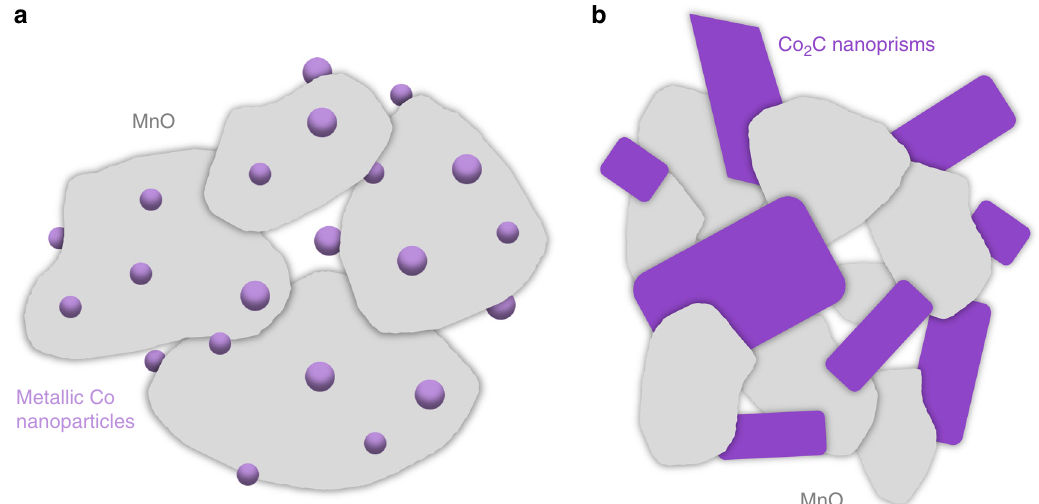
Fig. 7 Schematic drawing of the structure of the active catalysts based on TEM and XRD analysis. a Co 1 Mn 3 – Na 2 S consists of metallic Co nanoparticles of ~10 nm dispersed on MnO support and b Co 3 Mn 1 – Na 2 O consists of Co 2 C nanoprisms of ~10 – 50 nm from Zhong et al 8 . Whereas the former catalyst restricts WGS and thus CO 2 formation, the latter leads to large amounts of CO